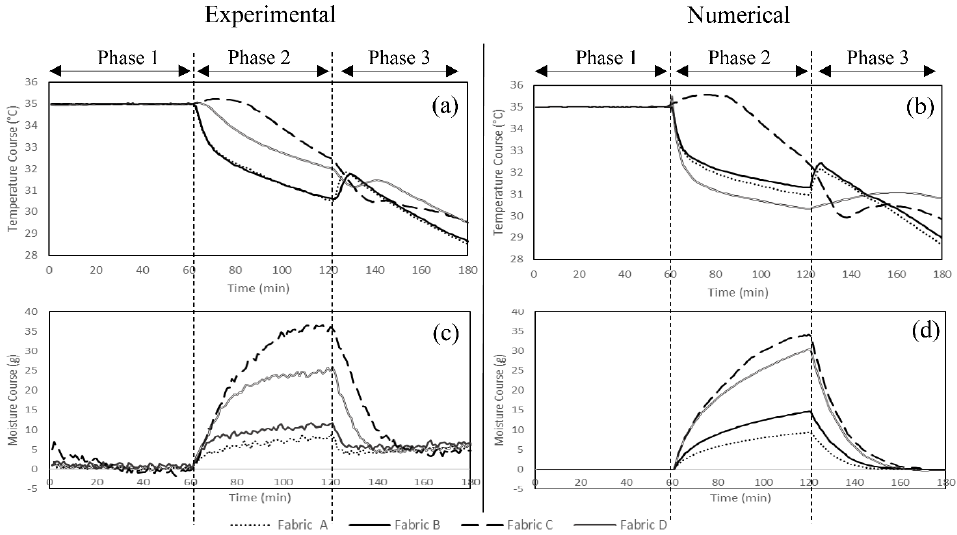
Figure 3. ( a ) Experimental and ( b ) numerical measurements of the temperature course and ( c ) experimental and ( d ) numerical measurements of the moisture course of the fabric systems during the 3 phases. Table 4. The experimental results of phase 2 of the standard experiment according to ISO 18640.